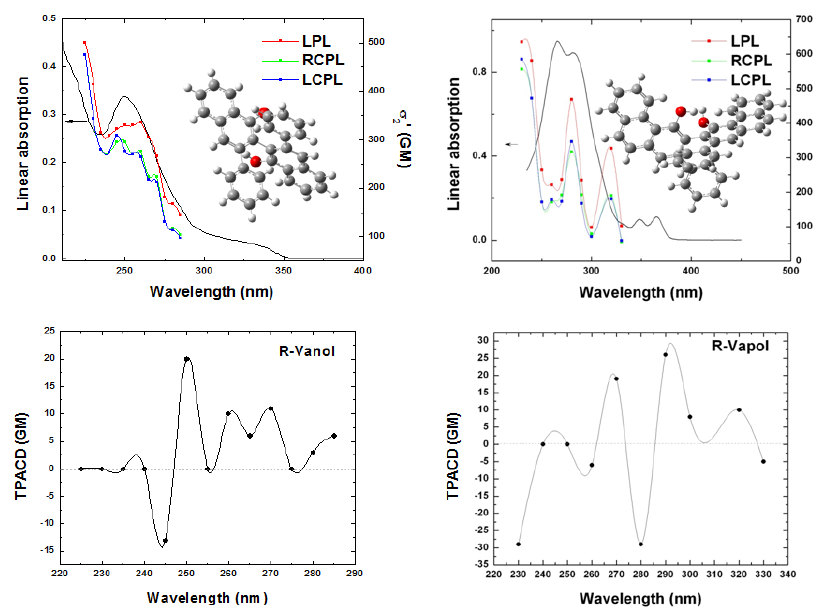
Figure 10. OPA and TPA spectra of R -VANOL/THF (top left) and R -VAPOL/THF (top right), exciting with different polarization states, LPL (red solid squares), RCPL (green solid squares) and LCPL (blue solid squares). TPACD spectra of R -VANOL/THF (bottom left) and R -VAPOL/THF (bottom